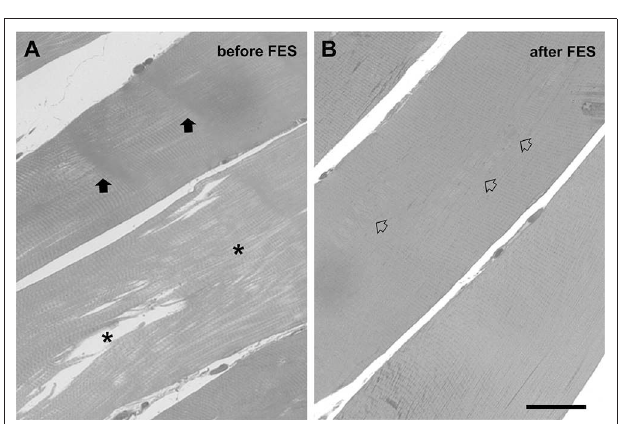
FIGURE 7 | Histological images from biopsies before (A) and after FES training (B) . Stars and arrows in (A) mark respectively fibers with unstructured cores and fibers with contracture cores . Empty arrows in (B) points to regions in which striation is not yet completely rescued. Scale bar: 20 µ